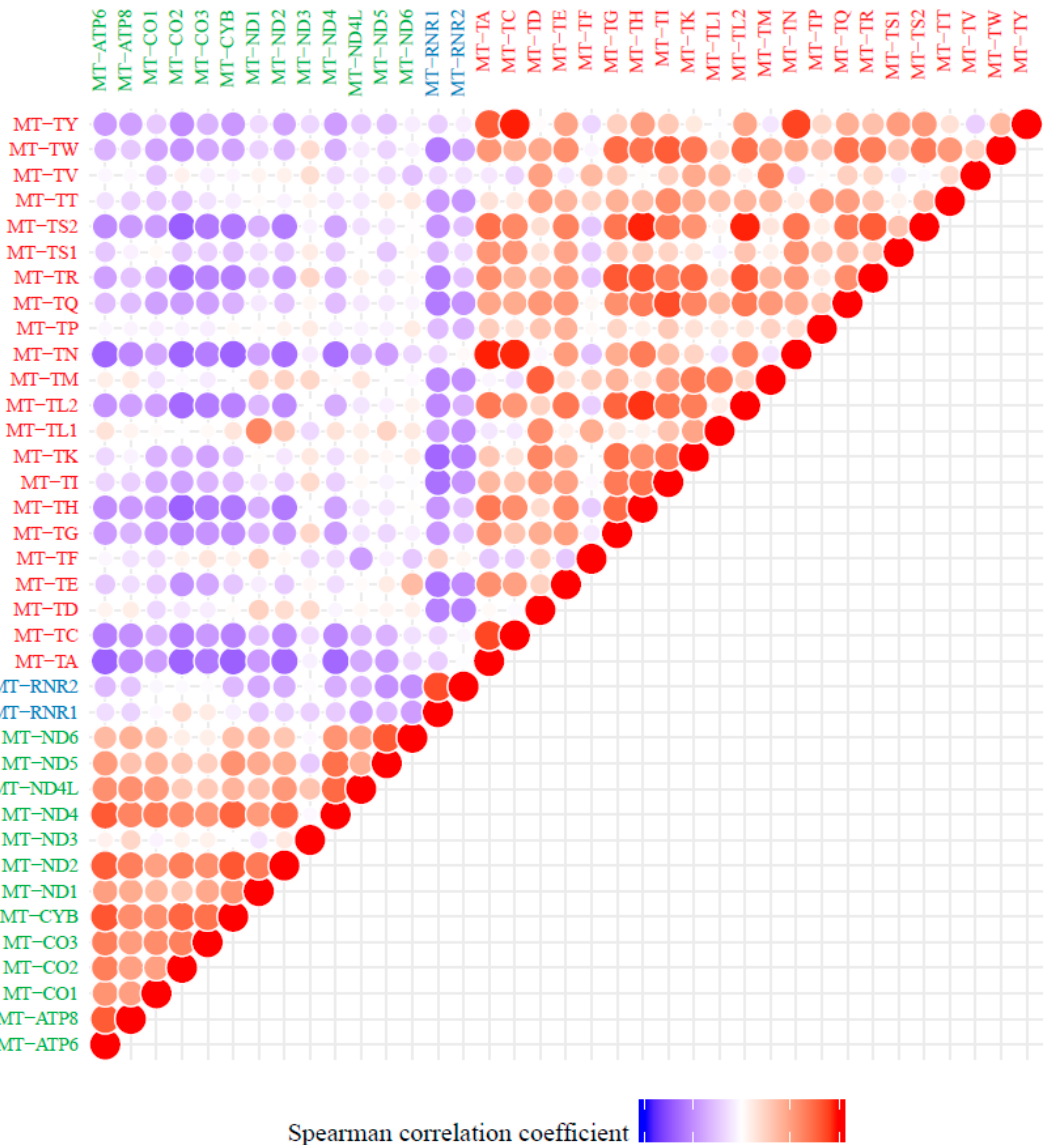
Figure 5. Correlation matrix of expression of all 37 mitochondrial-encoded genes of 344 primary breast tumor cases. Correlation matrix depicting the Spearman correlation between all 37 mitochondrial-encoded genes (text of tRNA genes in red, rRNA genes in blue, mRNA genes in green). Color intensity and the size of the circle are proportional to the correlation coefficients.